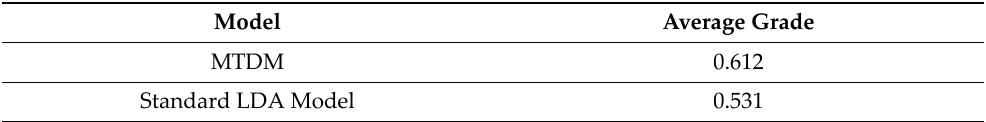
Table 6. Comparison results of MTDM and Standard